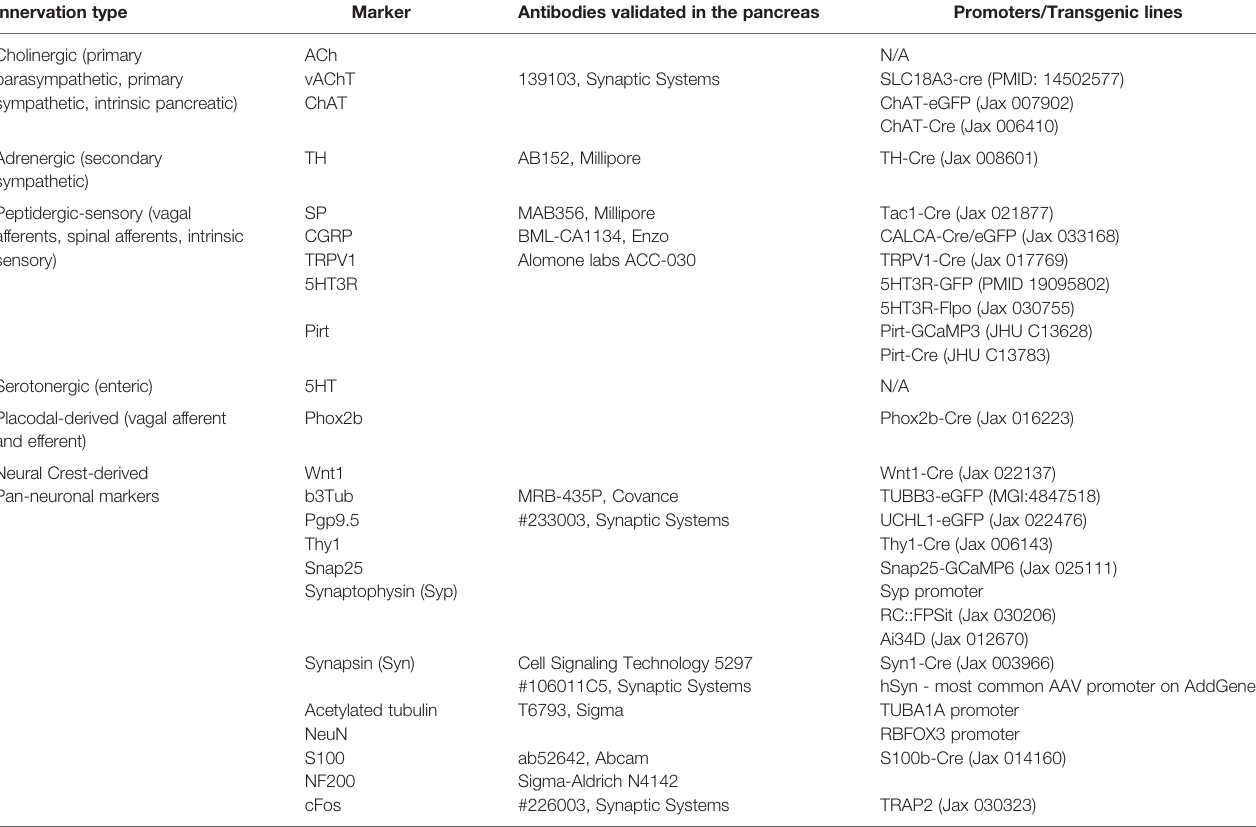
TABLE 2 | Neuronal markers, antibodies, mouse transgenic lines, and promoters for neuronal labeling.